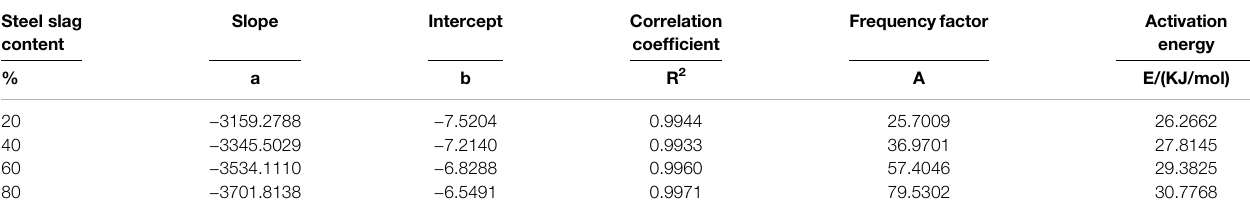
TABLE 4 | Calculation results of different ratios of sludge and steel slag cracking mechanism